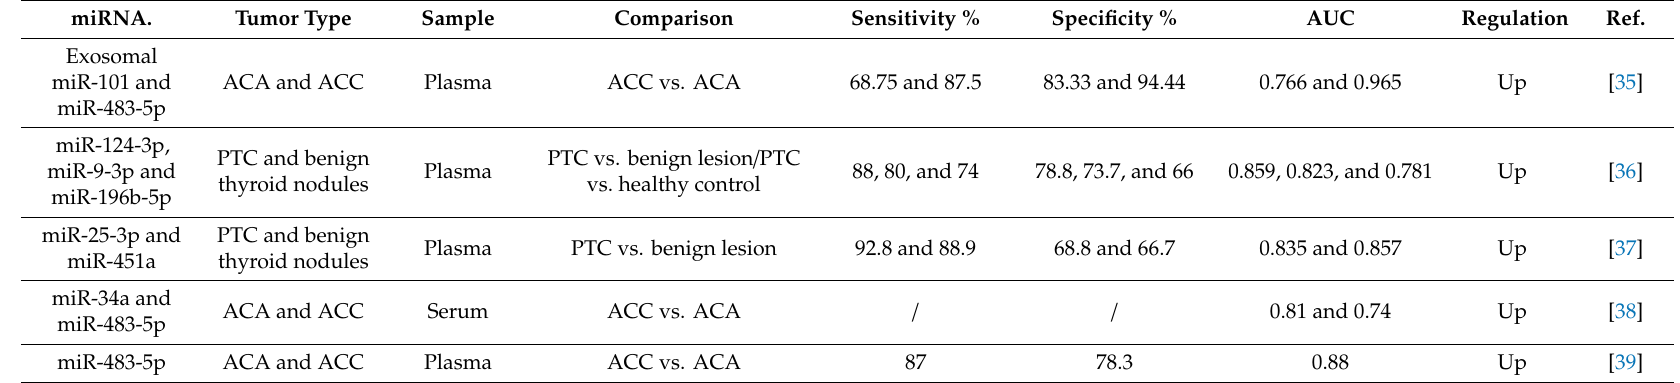
Table 2. Circulating miRNAs in Preoperative Endocrine